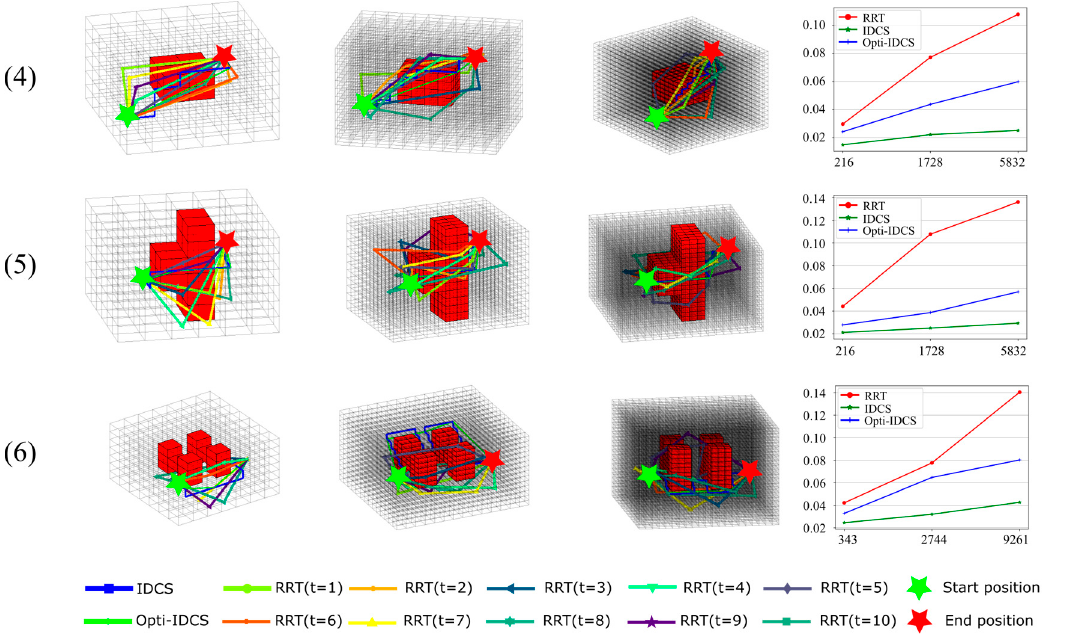
Figure 14. Relationships between the map size and calculation time. The first three columns are the maps with different resolutions, and the fourth column shows the relationship between the number of cells in the map and the time cost.